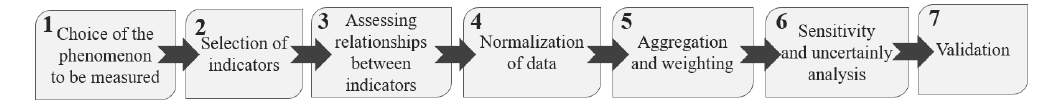
Figure 1. Overview of the different steps involved in constructing an index.